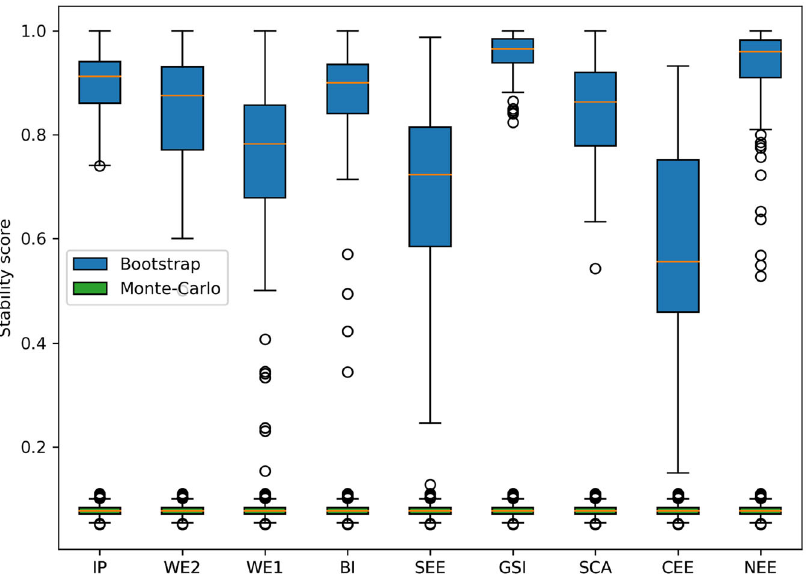
Fig. 2 Mean stability score per heatwave pattern. The stability score of bootstrap samples is compared to Monte-Carlo pseudo-experiments. The median in orange, end of the box, indicates the fi rst and third quartiles. The boundaries of the whiskers indicate the 1.5 interquartile range.